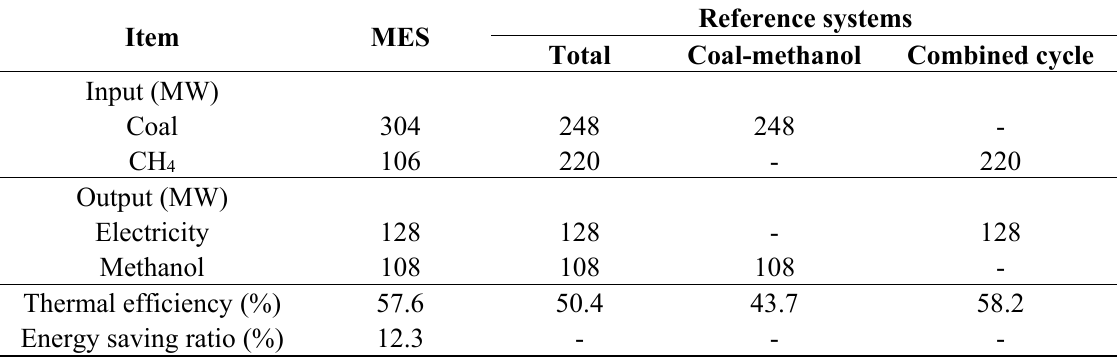
Table 2. Results for the new MES system and reference systems.